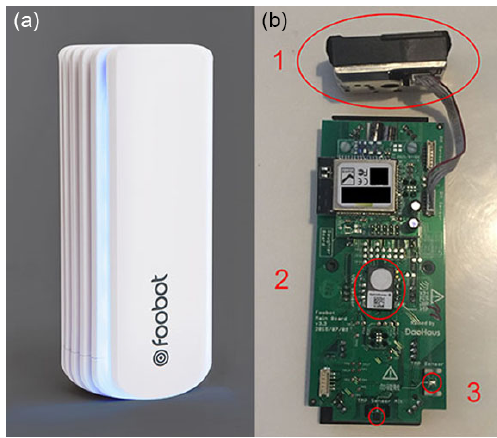
Figure 1. Foobot FBT0002100 monitor (a) and Foobot Main Board 3.3 (b) showing the SHARP GP2Y1010AU0F (1), the iAQ-CORE- C (2), and SHT20 (3). (a) from https://foobot.io (last access: 22 November 2017).